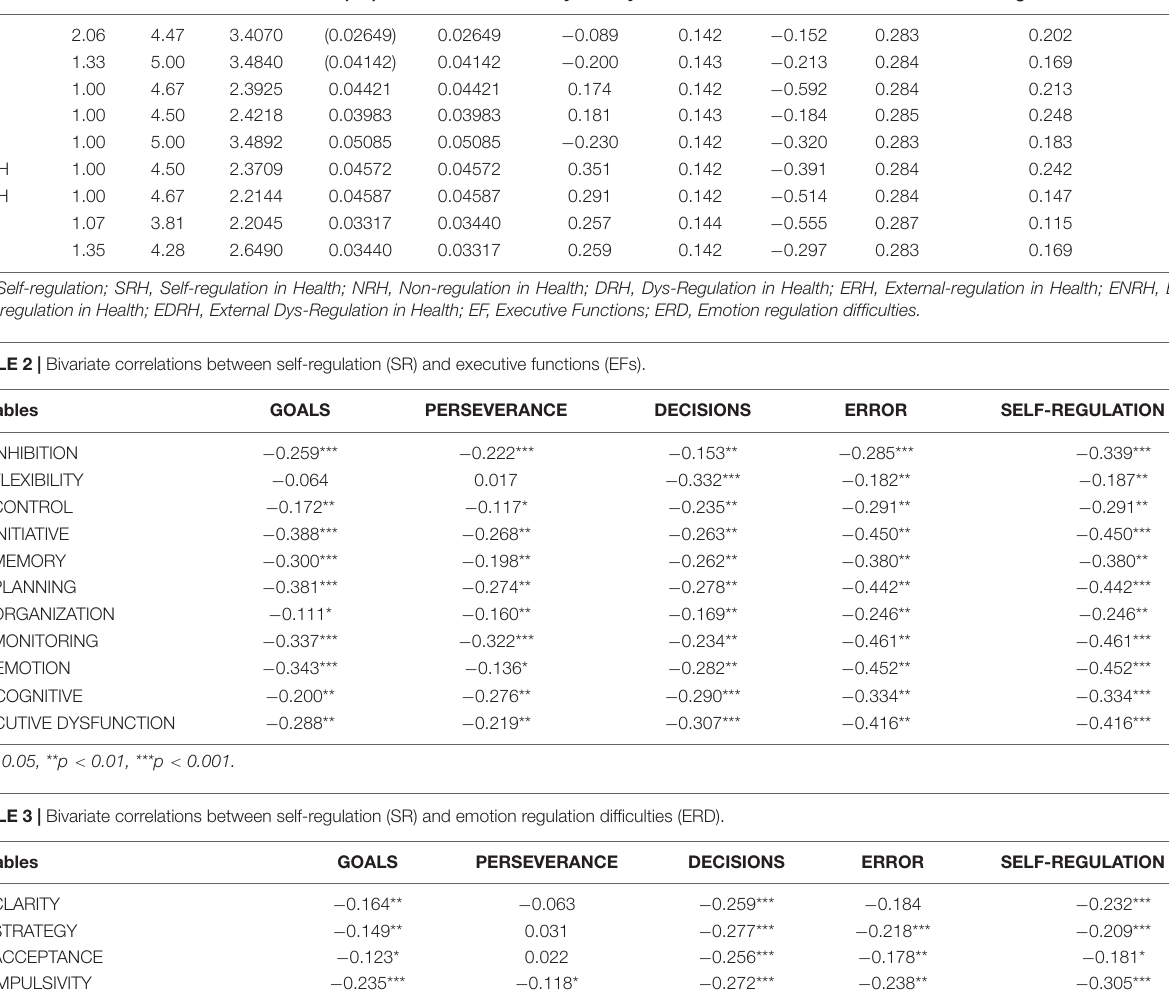
TABLE 1 | Normalized descriptive values of the sample. Variable Min.